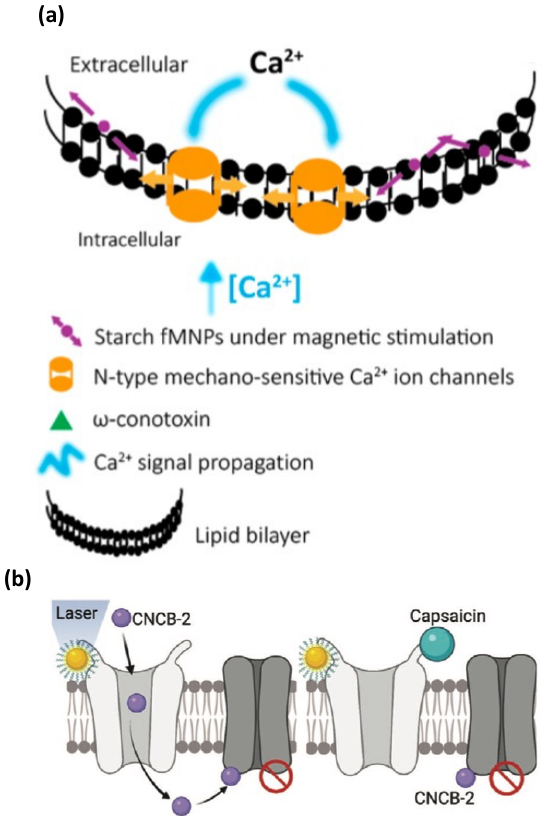
Figure 7. Graphical illustration of the mechanism of magnetic and plasmonic stimulation on neurons: ( a ) magnetic stimulation on magnetic NPs, which are located at cell membrane, to open mechanosensitive calcium channels (Copyright 2016 by ACS); ( b ) plasmonic stimulation of gold NPs to activate the opening of TRPV1 channel, and then allow the entrance of an N-type calcium-channel blocker (Copyright 2022 by Wiley).